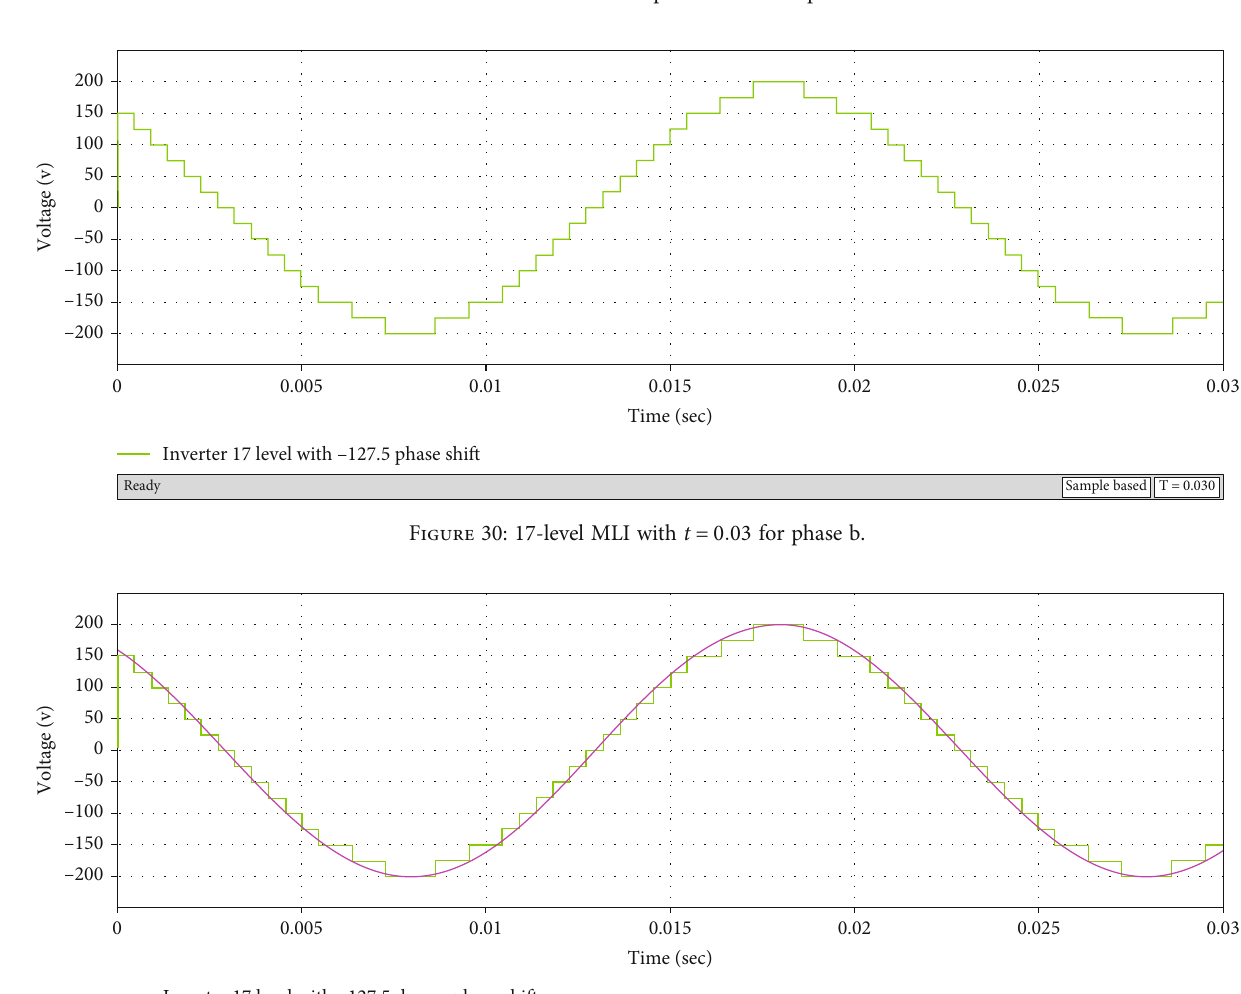
Figure 29: 17-level MLI with t = 0 : 03 for phase a and compared with sine wave.